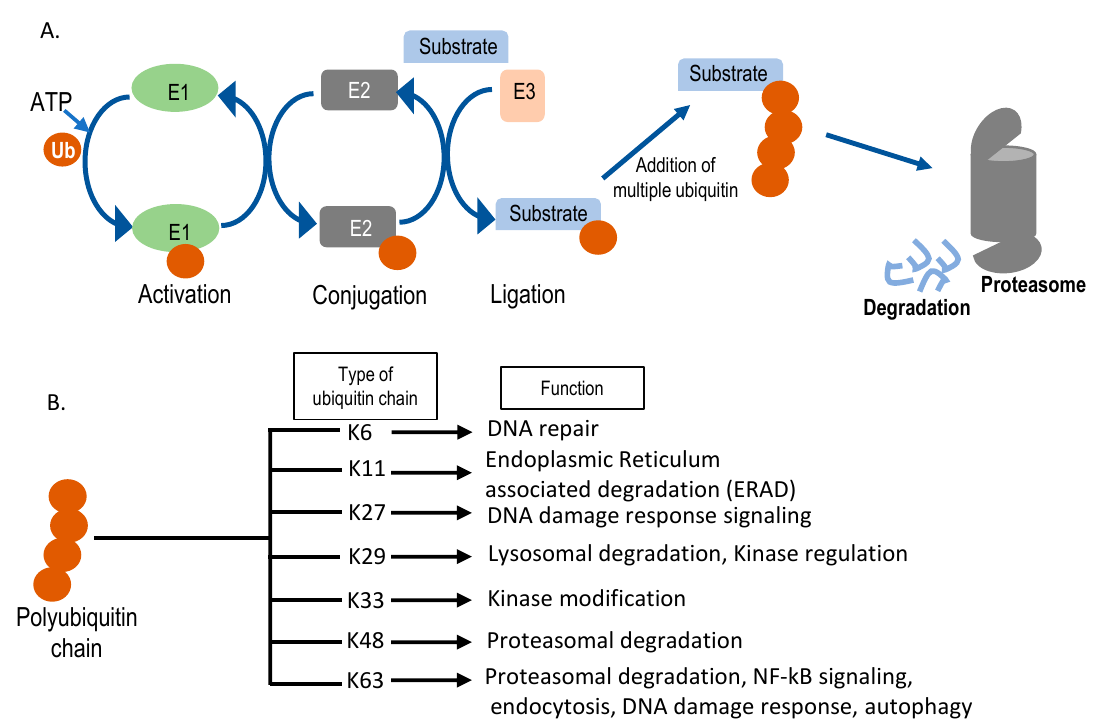
Figure 3. Schematic representation of the ubiquitin-proteasomal degradation pathway. ( A ) Sequential action of E1 (ubiquitin activating enzyme), E2 (ubiquitin conjugating enzyme), and E3 (ubiquitin ligase) enzymes in substrate ubiquitination. Ubiquitin is denoted as Ub. After multiple ubiquitin molecules are attached to the substrate forming lysine (K)-48, it can get degraded by the 26S proteasome. ( B ) Different kinds of polyubiquitin chains formed inside the cell and their cellular functions. Seven different ubiquitin lysine residues can be used for sequential chain formation and, based on the position of chain formation, functions vary.